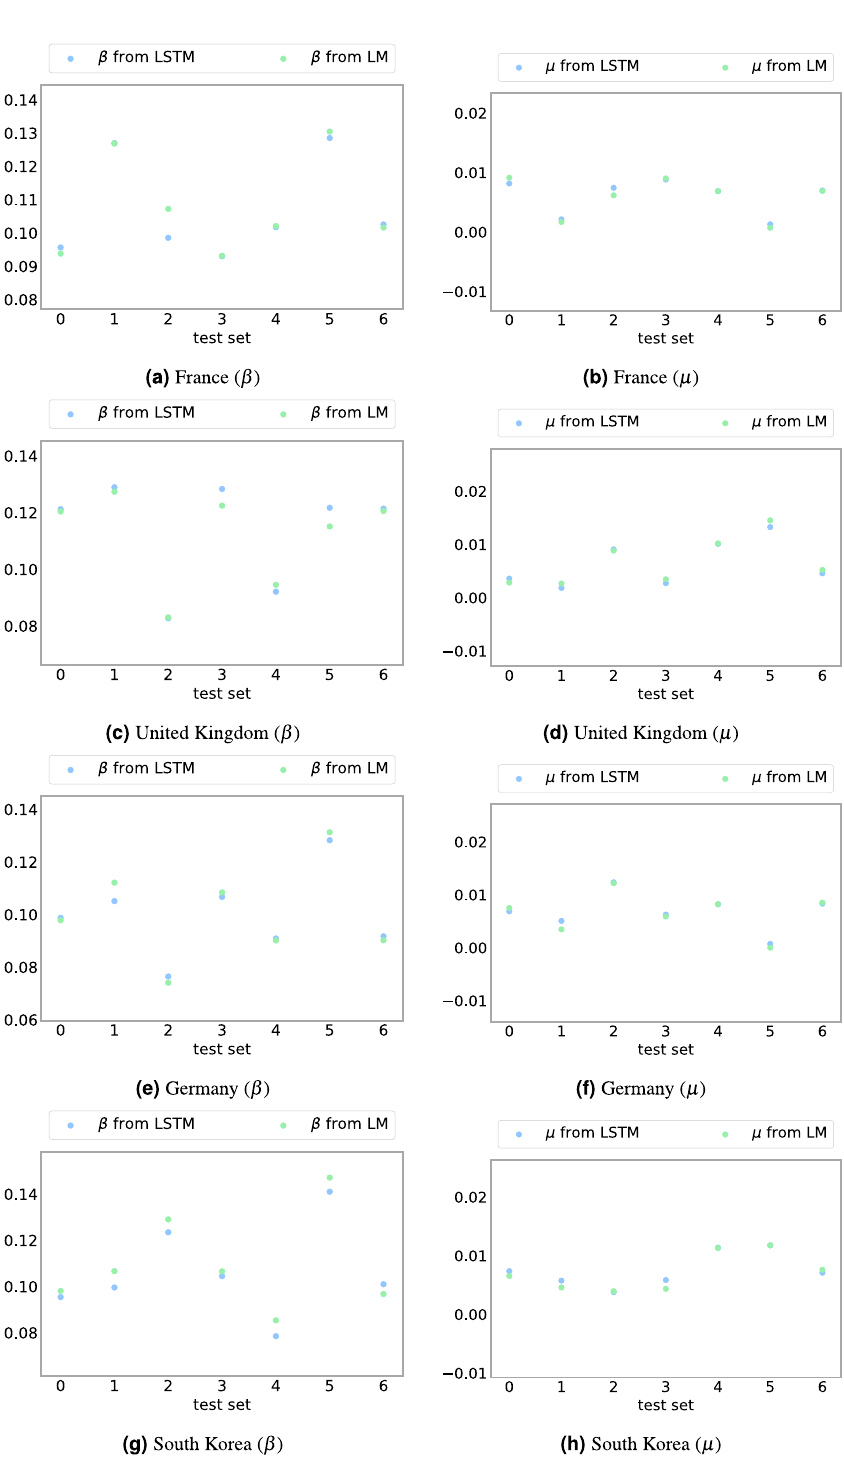
Figure 3. Comparison between (β , µ) computed by the Levenberg–Marquardt (LM) algorithm which is considered as our true data, and ( β , µ ) predicted from the LSTM networks for France, United Kingdom, Germany, and South